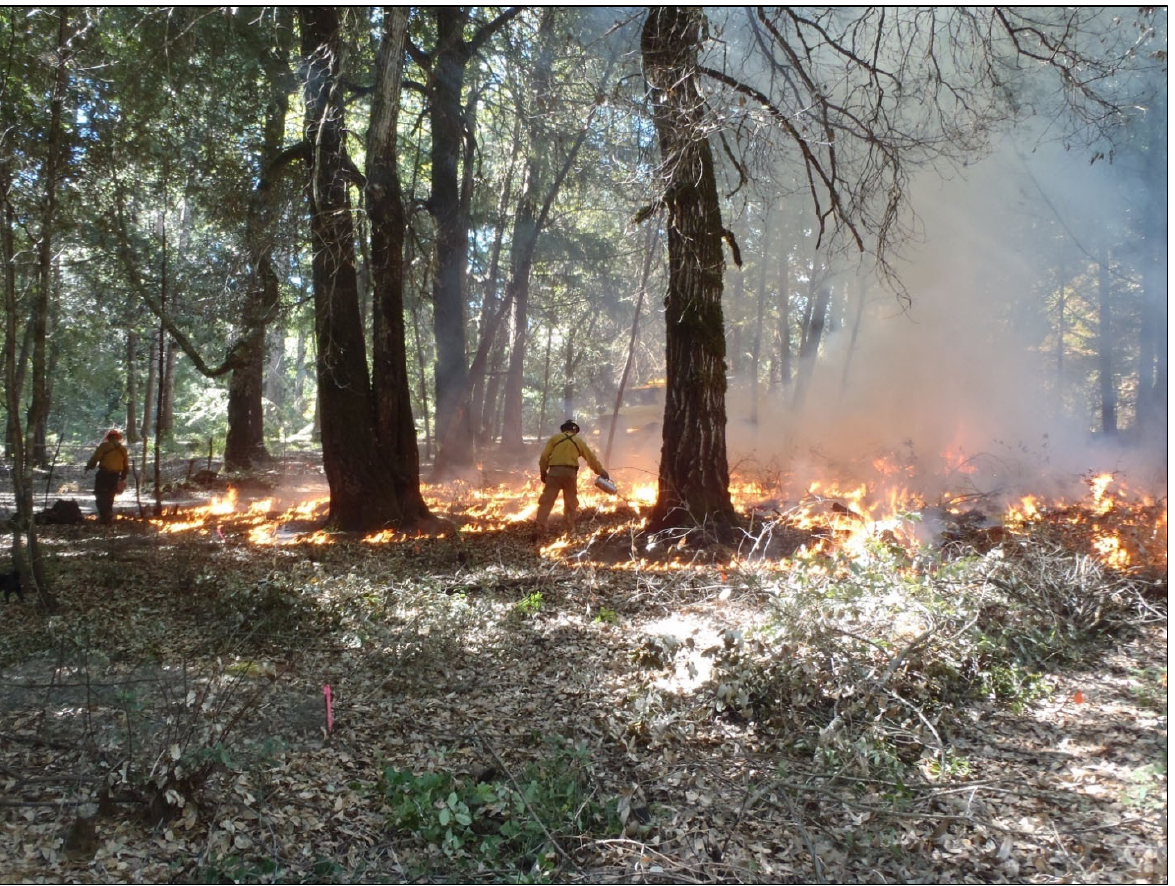
Figure 1. Using Culturally Appropriate Fire at the Base of Tanoak Acorn Trees to Support the Health of and Access to This Important Cultural Food for Middle and Lower Basin Tribes At Klamath River TREX (Training Exchange) in October 2015 near Orleans, California.